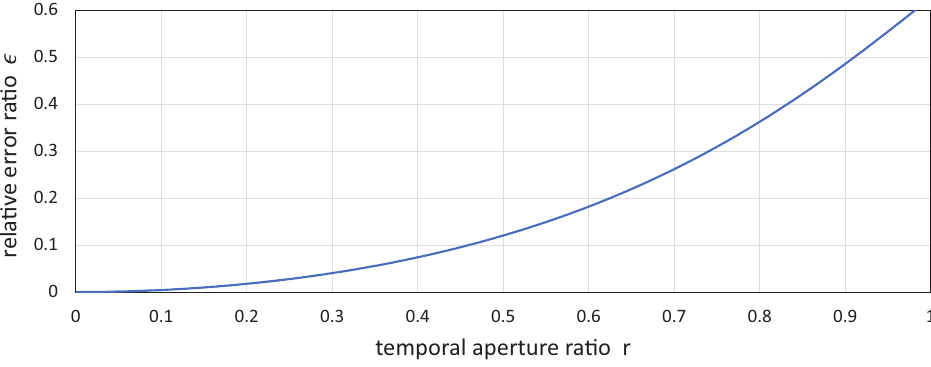
Figure 6. Relationship between temporal aperture ratio r and relative error ratio ε